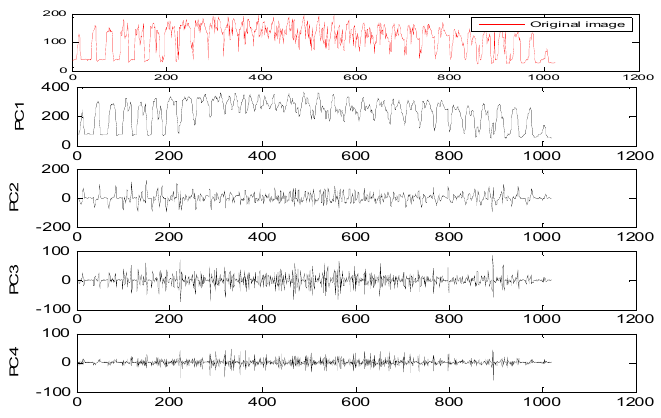
Figure 4. One-dimensional singular spectrum analysis (1D-SSA) of signal.